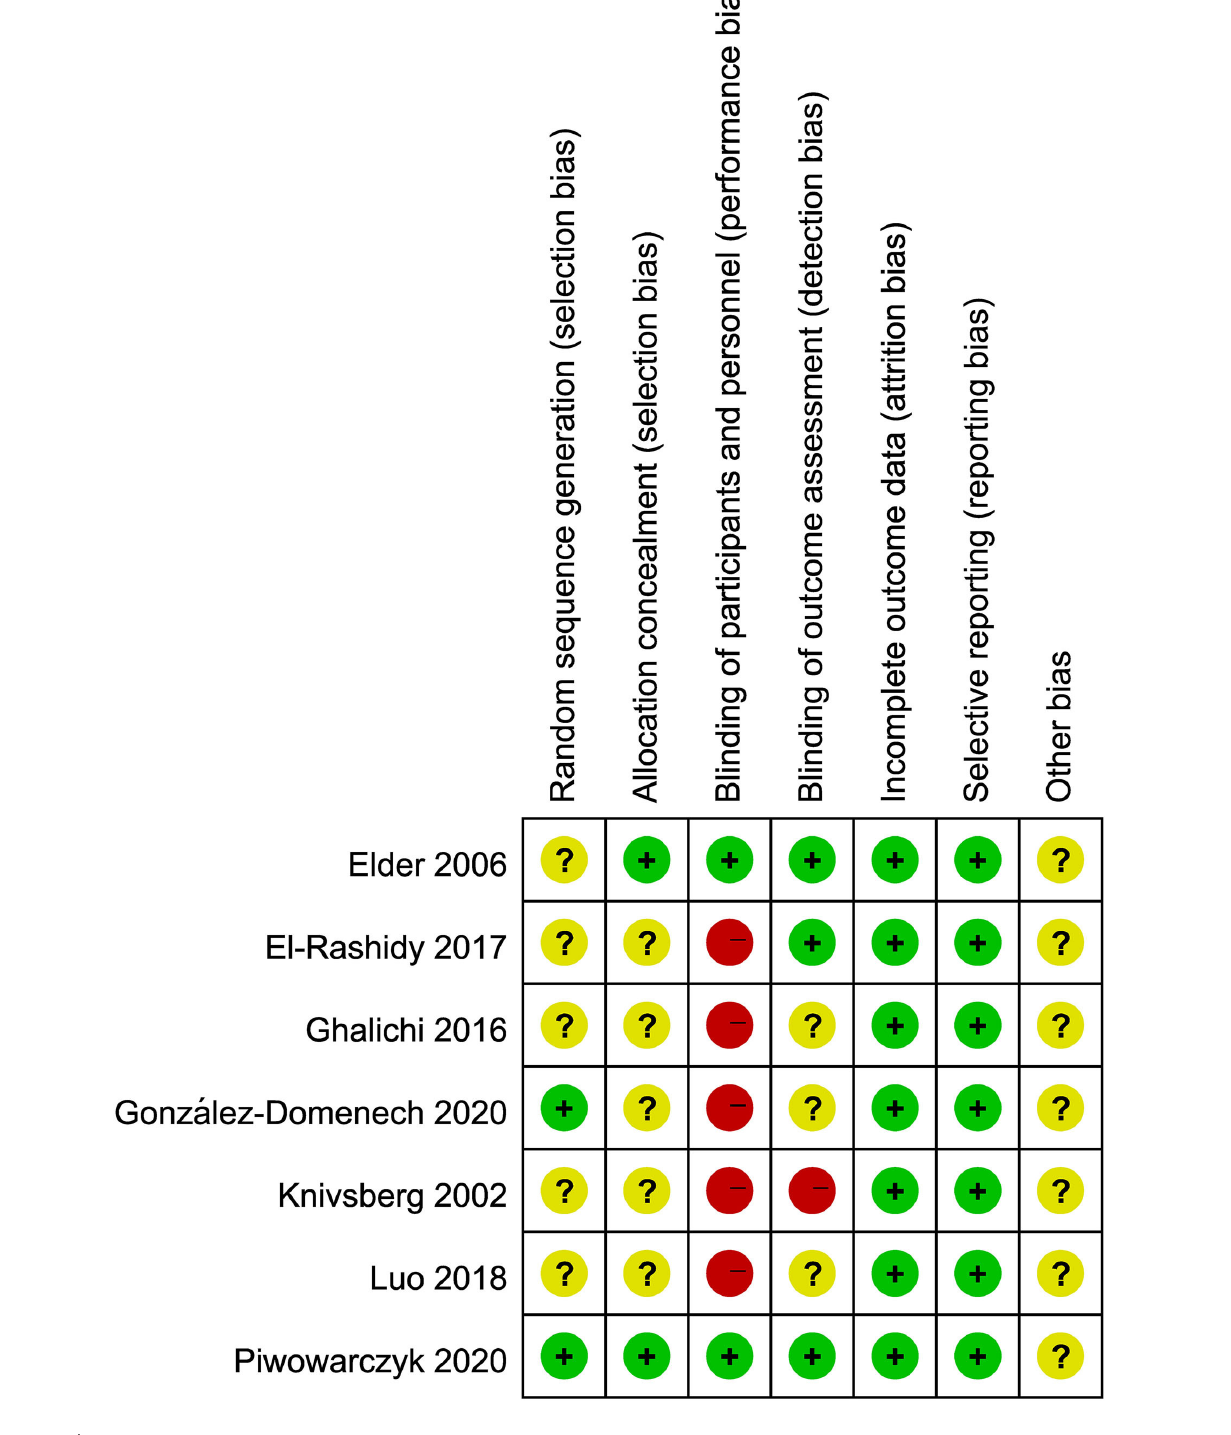
FIGURE 2 | Risk of bias